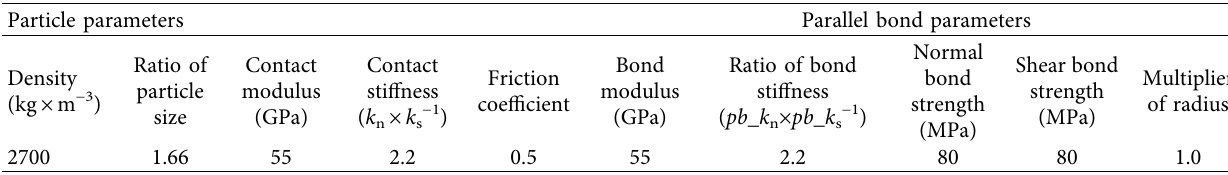
Table 2: Particles microscopic parameters of group B.